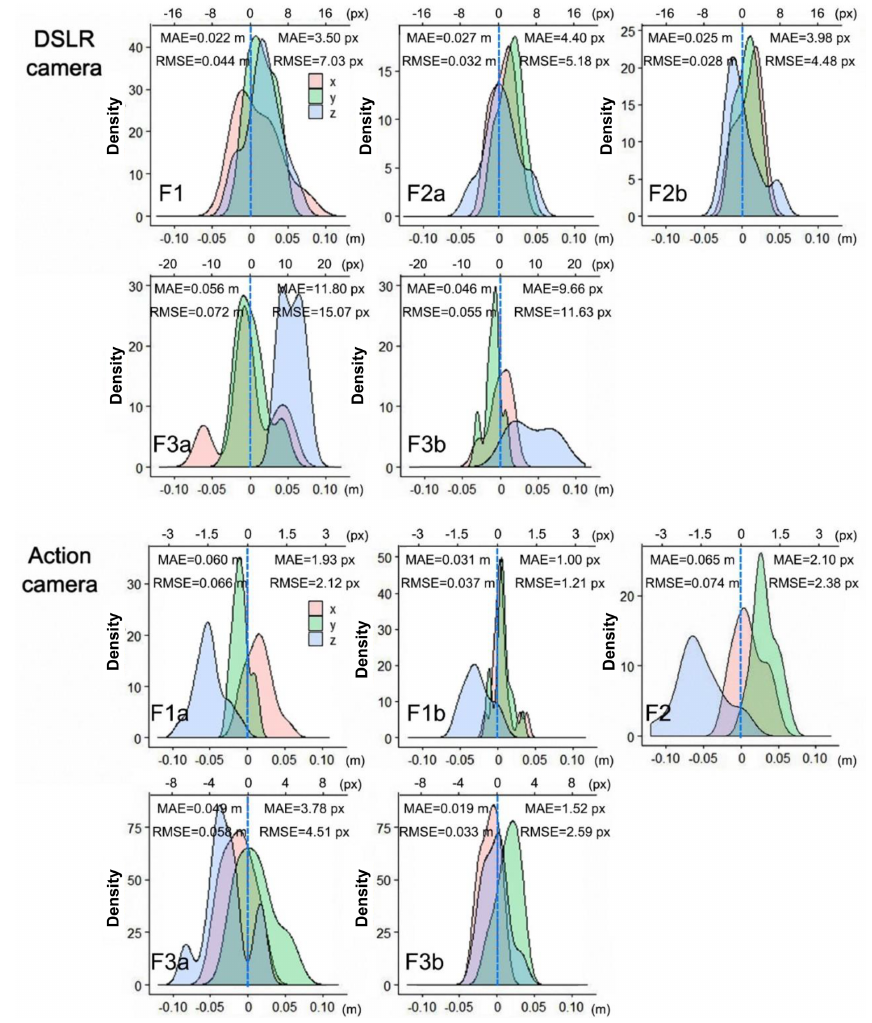
Figure 4. Distribution of CP residuals on the X , Y and Z directions of each survey. MAE and RMSE in the legend indicate mean absolute error and root mean square error of the XYZ direction. Units are given in meters as well as pixels to standardize results in terms of the expected error incurred from the GSD at the corresponding flight